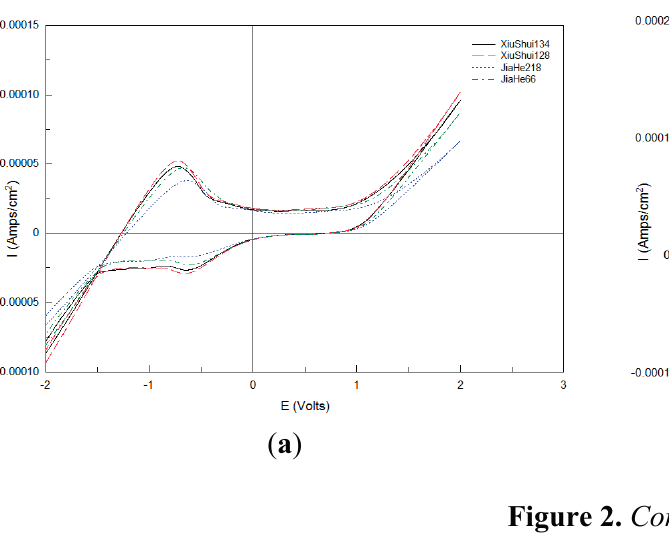
Figure 1. Voltammograms of four crushed rice sample solutions obtained using four electrodes. ( a ) Pt electrode; ( b ) Ag electrode; ( c ) Au electrode; ( d ) Pd electrode.